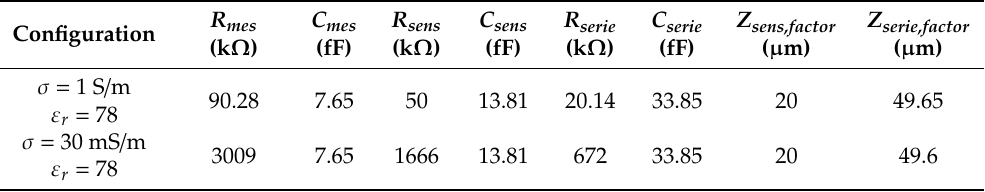
Table 2. Simulated capacitance (in fF) for first- and second-generation sensors.